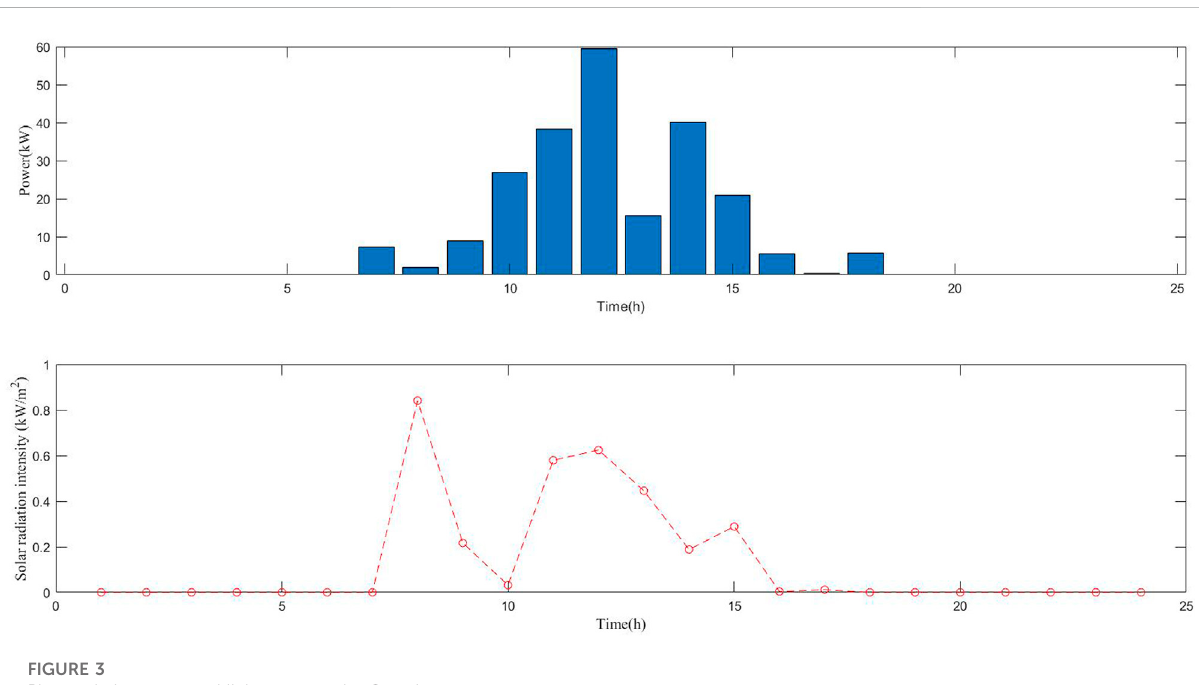
FIGURE 3 Photovoltaic output and light curve under Case 1.